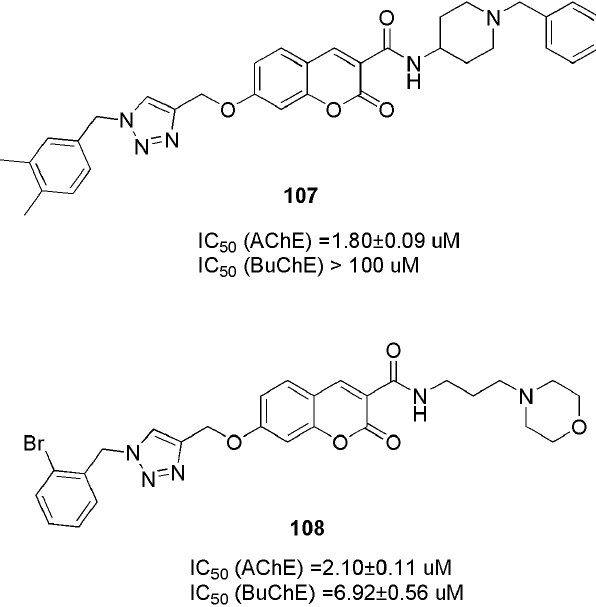
Figure 41. Chemical structure and IC 50 values of compounds 107 and 108.